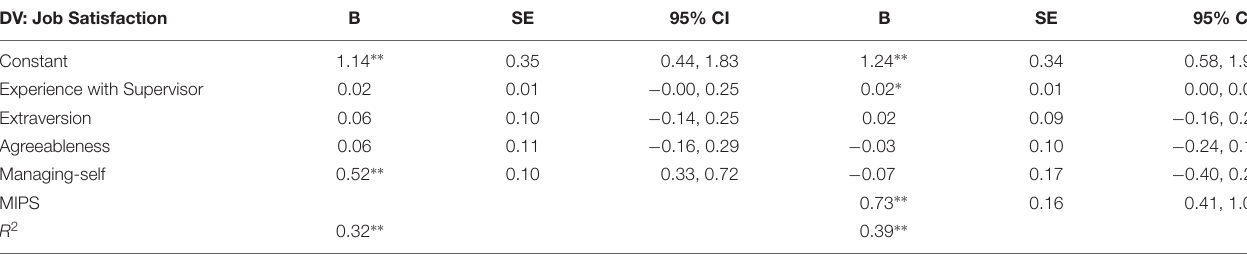
TABLE 2 | Criterion-related validity – Study